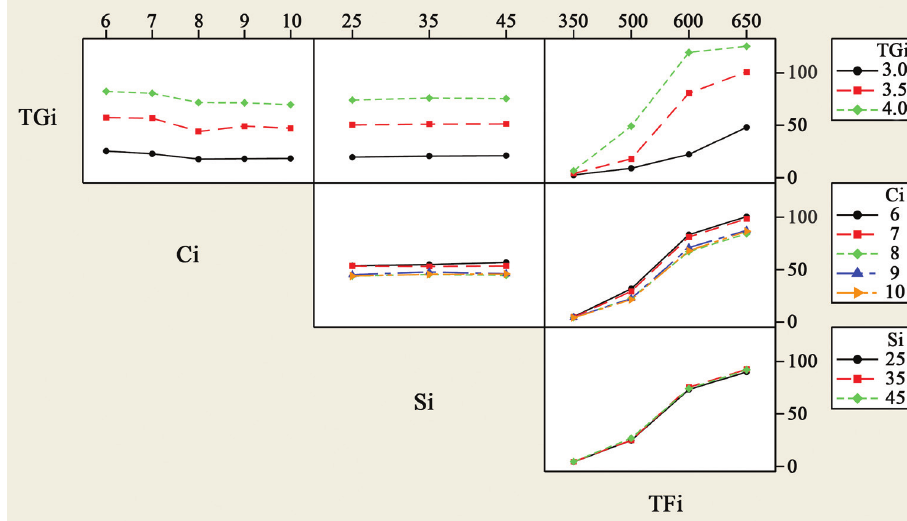
Fig. 8. Interaction plots for stop-line delays in C